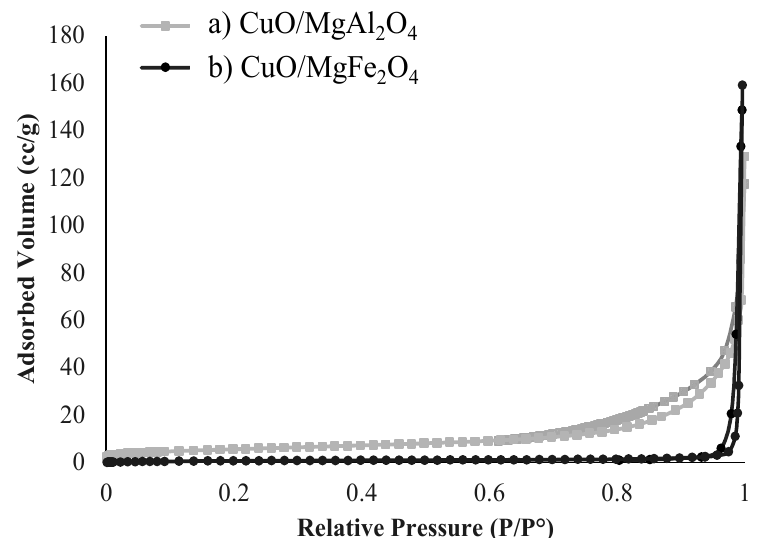
Figure 7. Adsorption / desorption isotherms of the nanocatalysts ( a ) CuO / MgAl 2 O 4 and ( b ) CuO / MgFe 2 O 4.